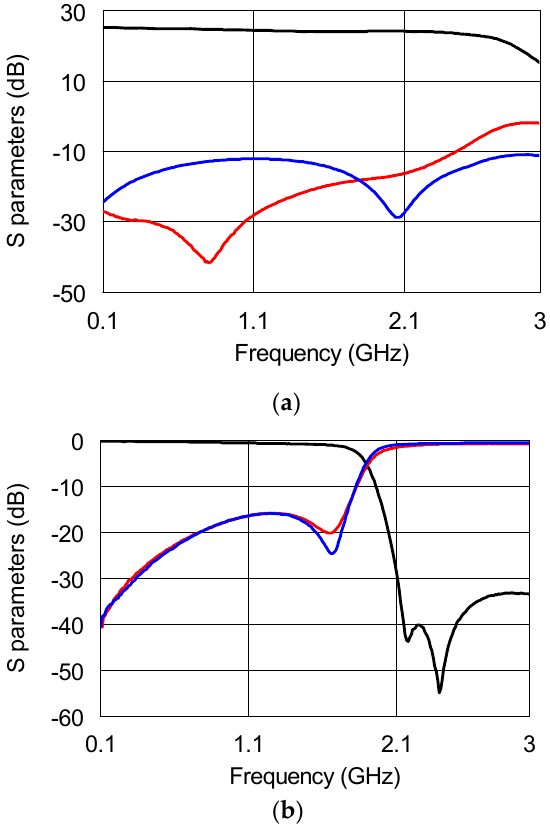
Figure 6. Measured S 21 (black solid line), S 11 (blue solid line), and S 22 (red solid line) of the ( a ) ZFL-1500VH+ amplifier and ( b ) VLF-1500+ filter.